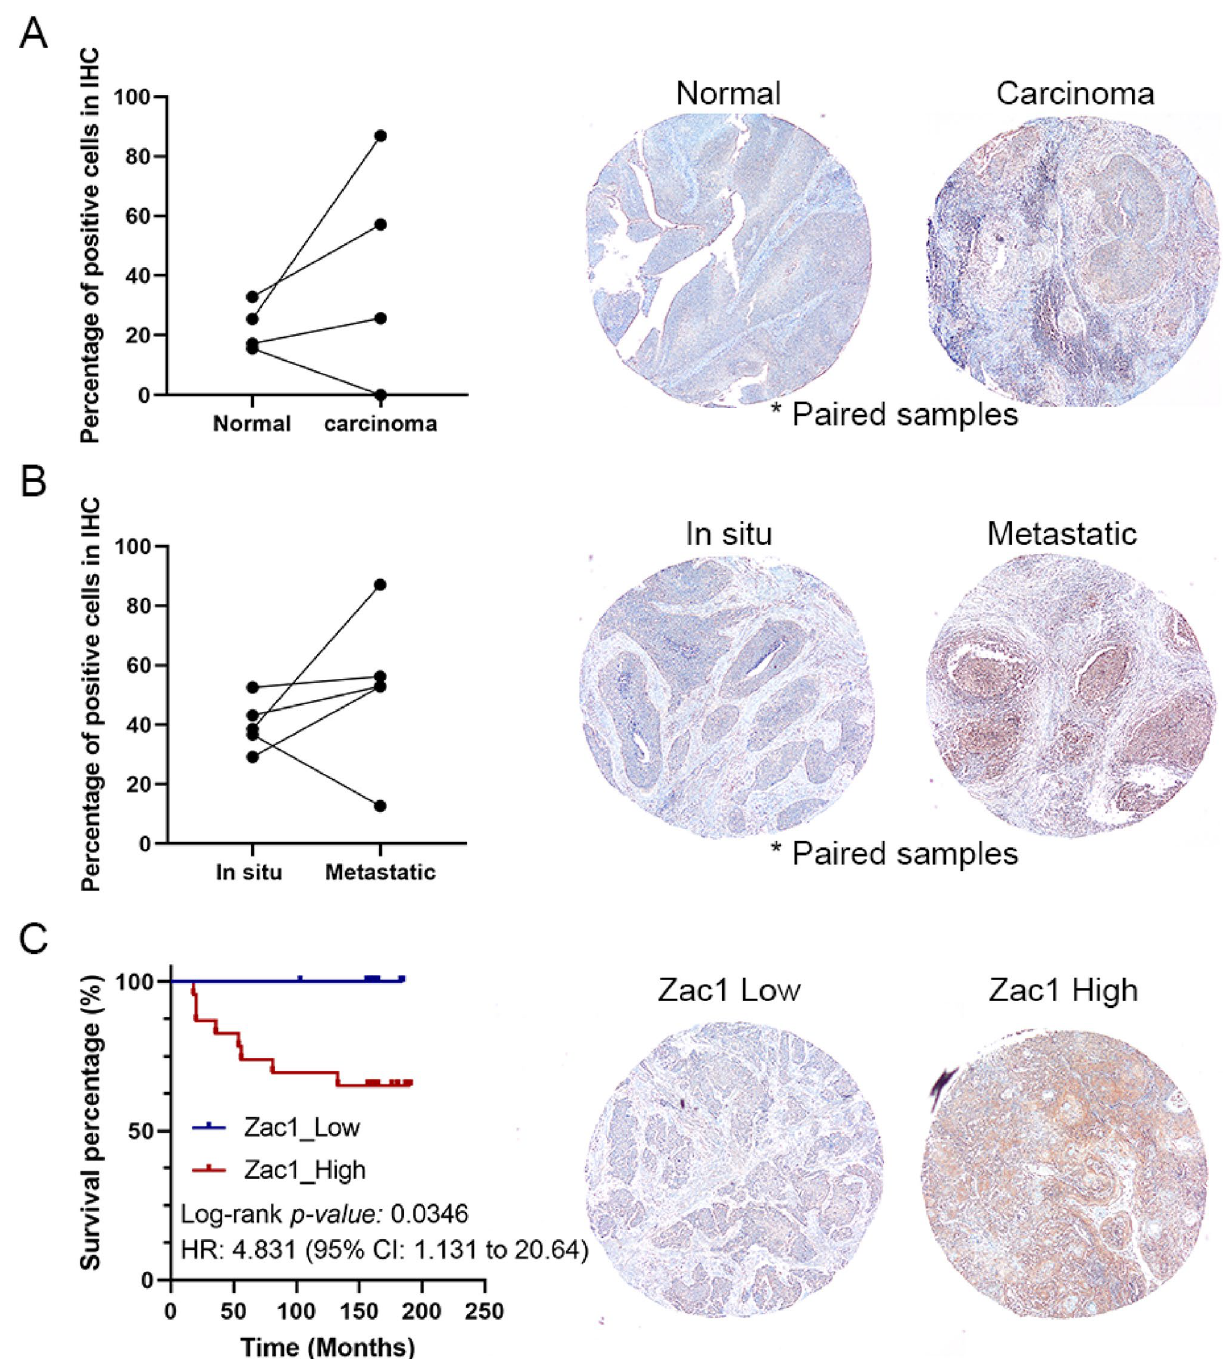
Figure 8. Tissue-array based immunohistochemical (IHC) analysis illustrate Zac1 expression in cervical carcinoma tissues. IHC stains of (A) matched normal and tumor tissues; (B) matched carcinoma in situ and metastatic carcinoma in lymph node; (C) tumor biopsies with Zac1_Low and Zac1_High were selected as representative results. Dot plots show the percentage of positive cells in each sample identified by IHC profiler using ImageJ (Fiji). Lines connecting dots represent the matched tumor biopsies. Kaplan Meier survival analysis showed that in cervical carcinoma with lower Zac1 expression had a better overall survival compared to higher Zac1 expression (log-rank P =